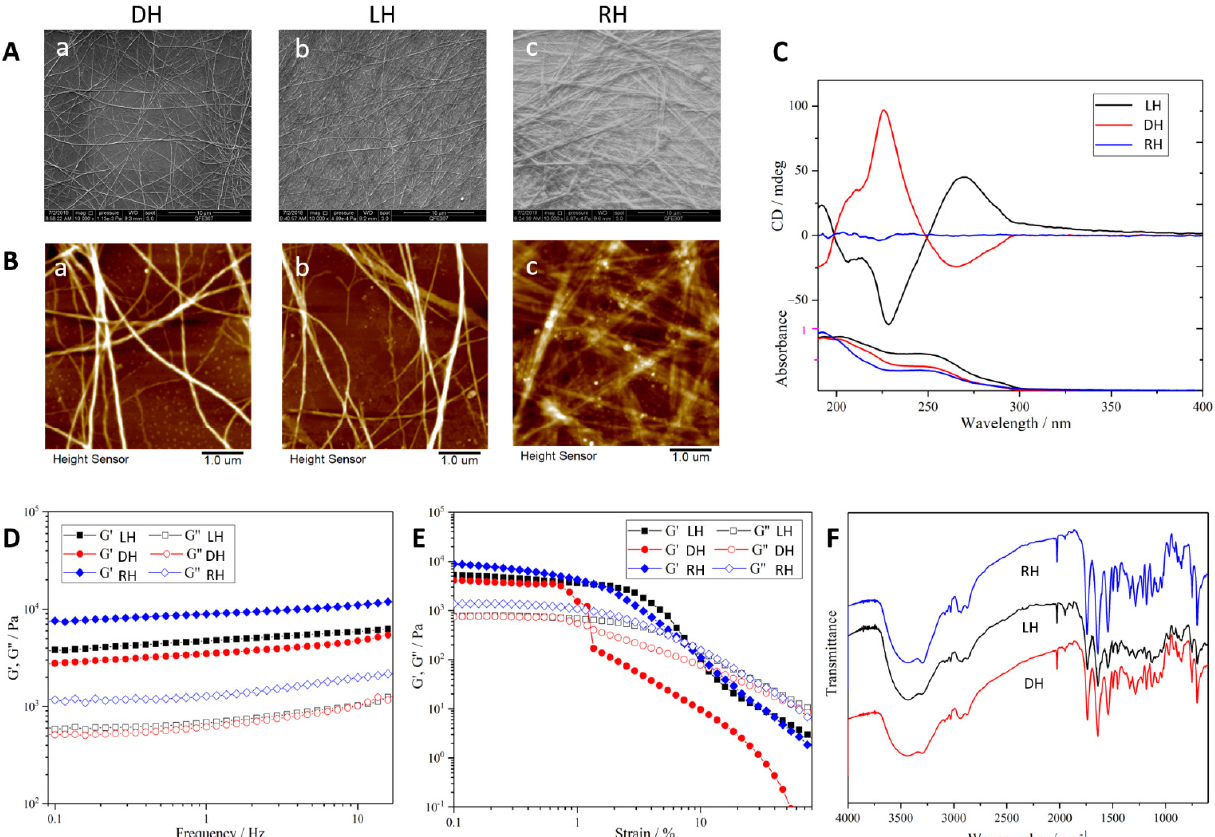
Figure 1. Characterization of chiral supramolecular hydrogels. ( A ) SEM images of different chiral supramolecular hydrogels. DH (a), LH (b), RH (c), scale bar = 10 µ m; ( B ) AFM image of different chiral supramolecular hydrogels. DH (a), LH (b), RH (c), scale bar = 1 um; ( C ) CD spectroscopy; ( D ) FTIR spectra; ( E , F ) rheology of hydrogels assessed by rheometer.